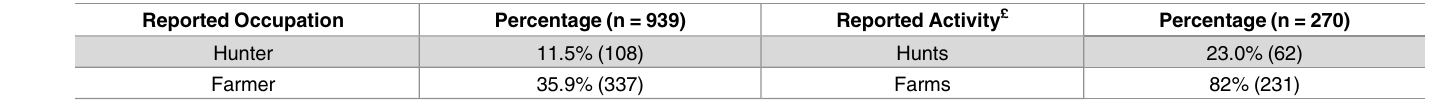
Table 2. Comparison of Occupation to Reported